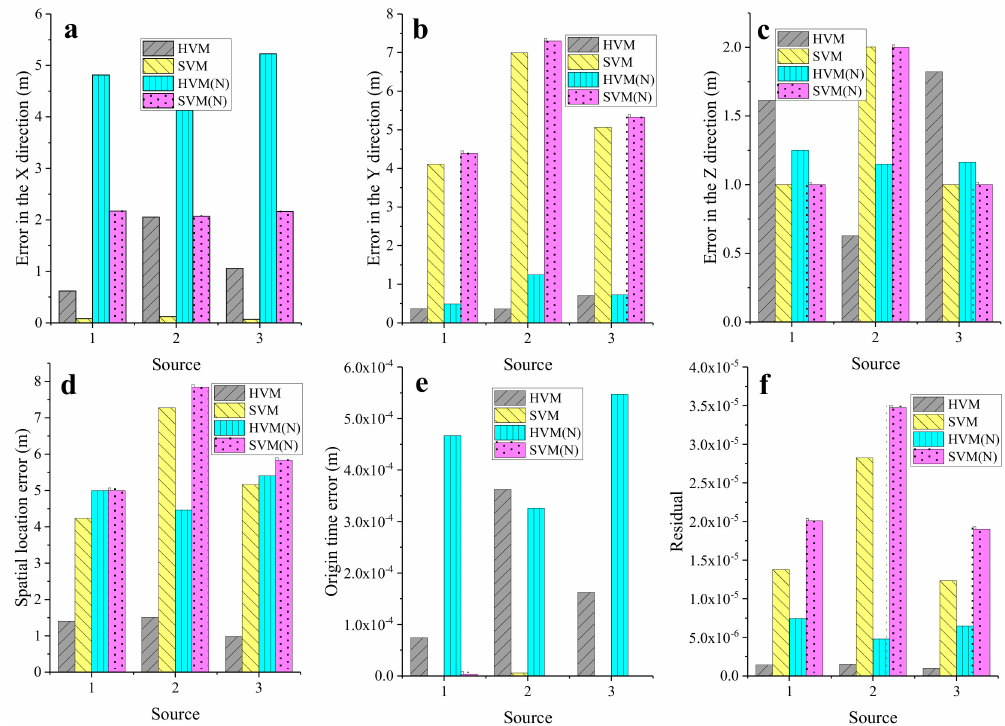
Figure 8. Error of location results of the four experiments: ( a ) error in the X direction, ( b ) error in the Y direction, ( c ) error in the Z direction, ( d ) spatial location error, ( e ) origin time error, and ( f )